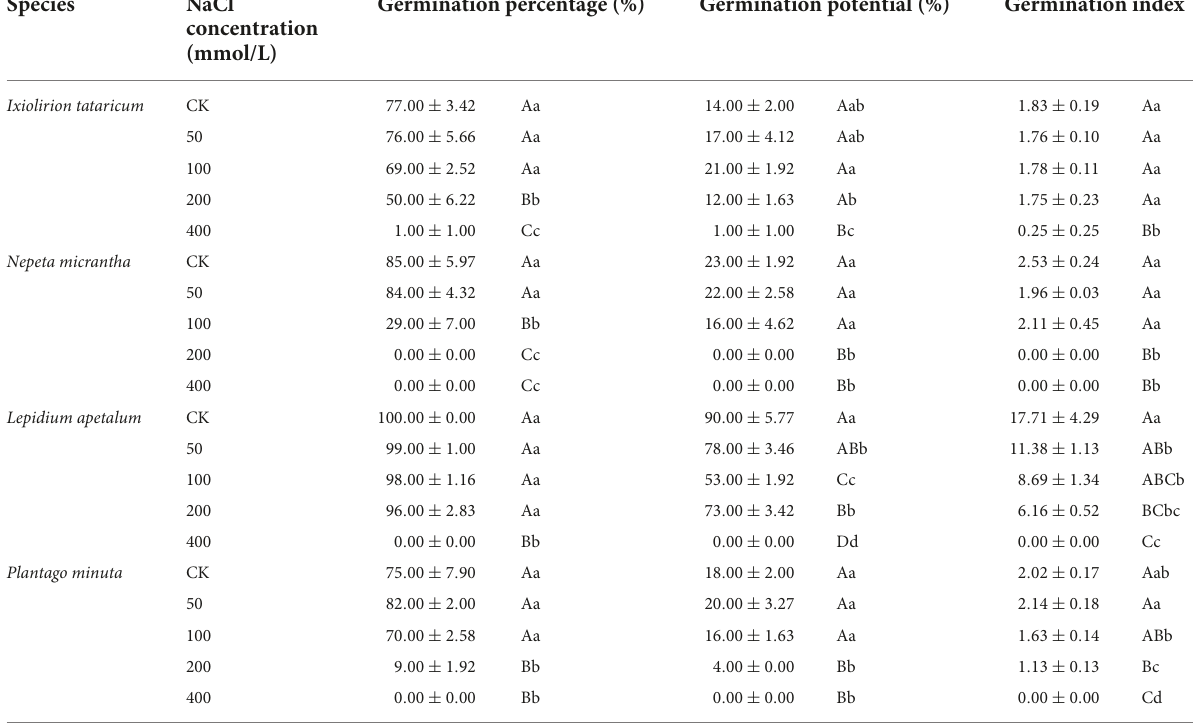
TABLE 1 Effects of different concentrations of NaCl on germination percentage, germination potential, and germination index. Species NaCl Germination percentage (%) Germination potential (%) Germination concentration (mmol/L)